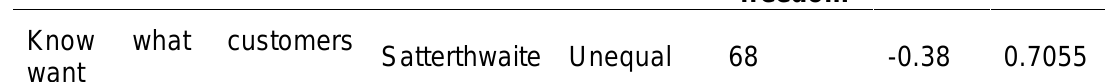
Table 3: Significant Differences Relating to Know What Customers Want